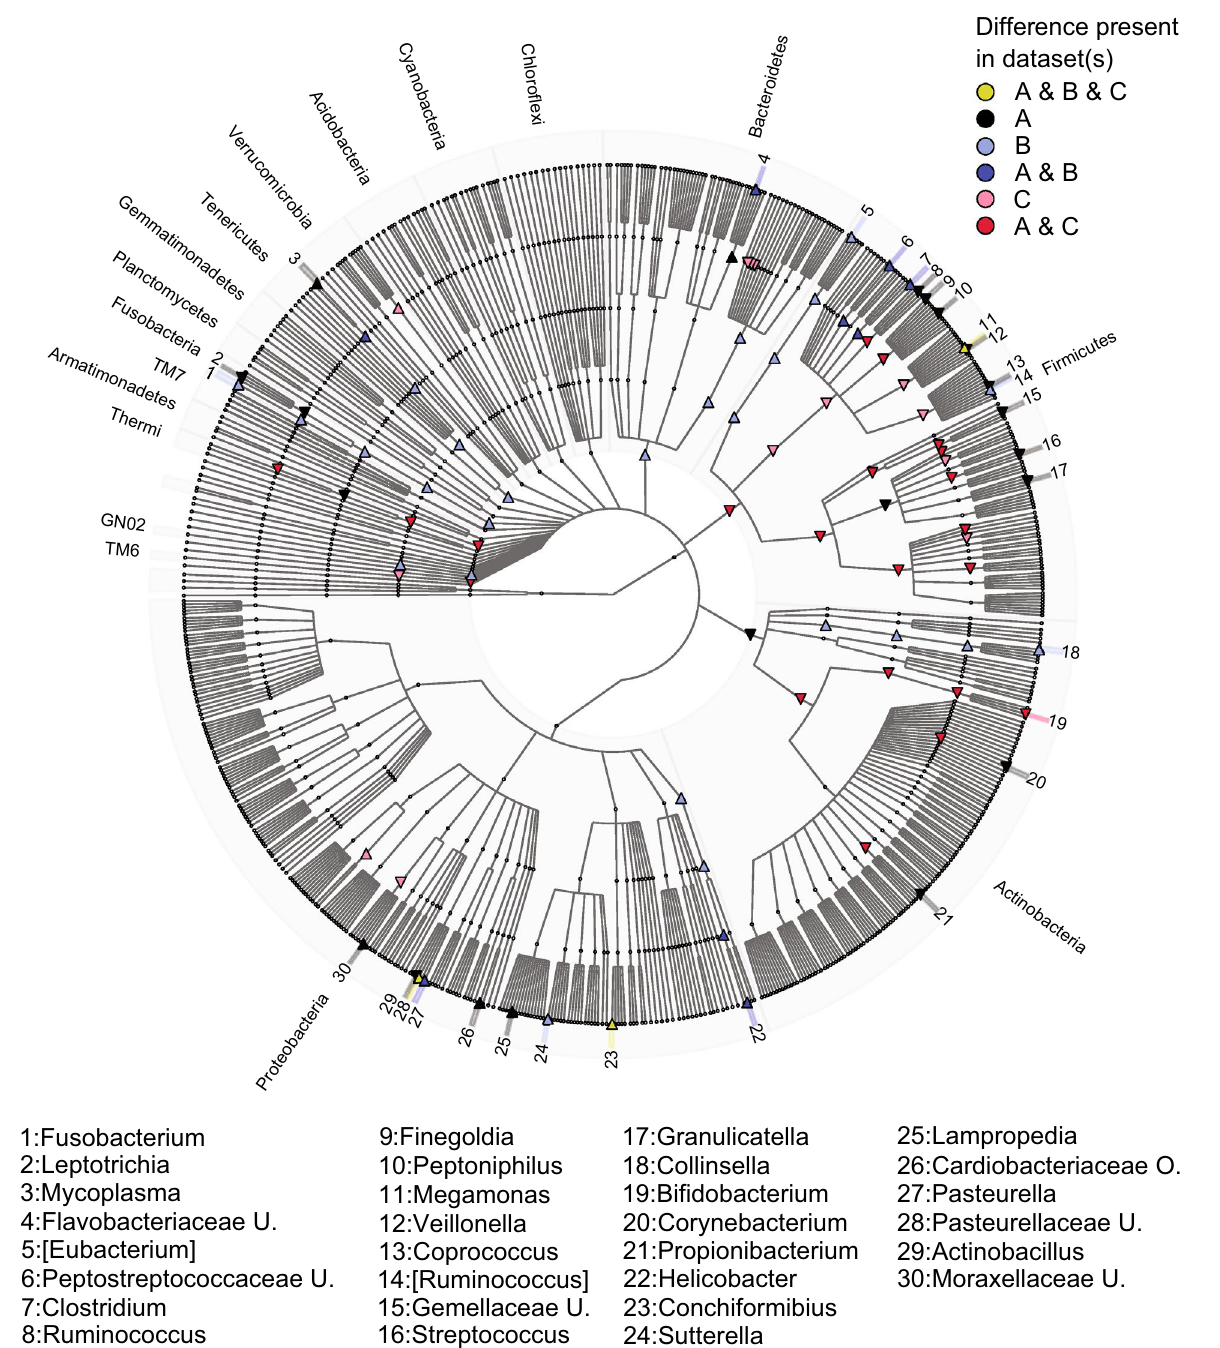
Figure 4. Bacterial taxa associated with dog and non-dog homes in LUKAS2 cohort, determined by ANCOM. Cladogram is additionally stratified by the sampling time: snow cover and no-snow cover. From the highest rank to the lowest, the major taxonomic ranks are domain (in the middle), phylum, class, order, family and genus (in the farthest layer). Genera that differ between the dog homes and non-dog homes are numbered in the figure. U. denotes “unassigned”, O. “other” genus within a family, and brackets indicate candidate taxonomy. Three datasets were created [( A ) the whole cohort, ( B ) only samples, when snow was on the ground, and ( C ) only samples without snow on the ground] for this phylogenetic tree. If the top of triangle is pointing up, the relative abundance of the taxa is higher in dog homes. If the top of triangle is pointing down, the relative abundance of the taxa is lower in dog homes than non-dog homes. Yellow = the difference is found in all three datasets; black = the difference is seen only when the whole cohort is used (dataset A ), but the difference disappears when data stratified by snow cover; light blue = the difference is only found when snow is on the ground (dataset B ); dark blue = the difference is found in the whole cohort and when snow was on the ground (datasets A and B ); light red = the difference is seen only without snow cover (dataset C ); dark red = the difference is seen with the whole cohort and without snow cover (datasets A and C ), but not when snow